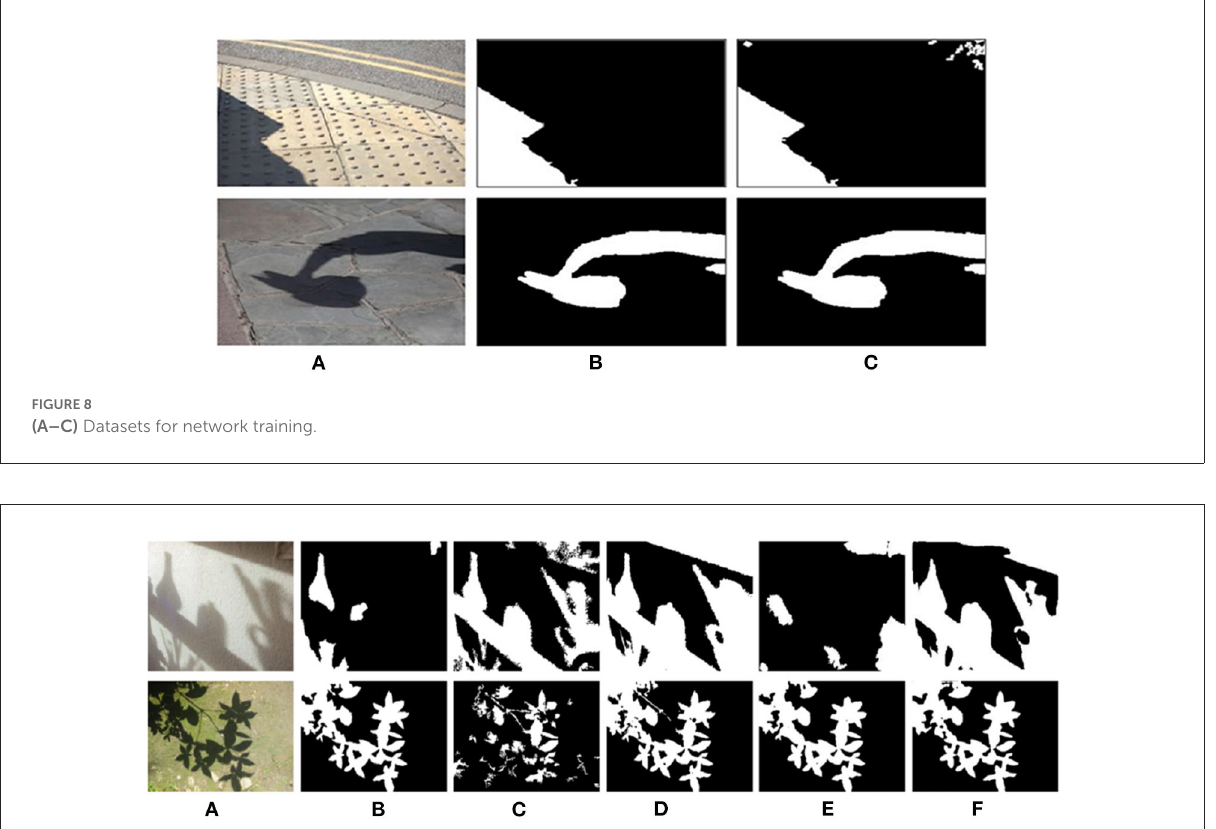
FIGURE9 Detection results with different methods on ISTD dataset. (A) Shadow image, (B) GT, (C) GSCA-Unet, (D) SAS, (E) DSAN, and (F) Proposed.